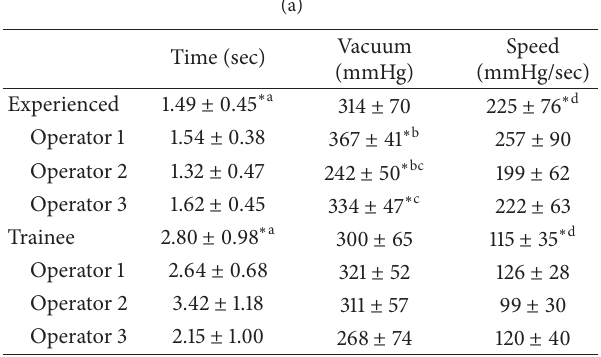
Table 1: Timetomaximum vacuum (time), maximum vacuum level (vacuum), and speed of increase in vacuum level